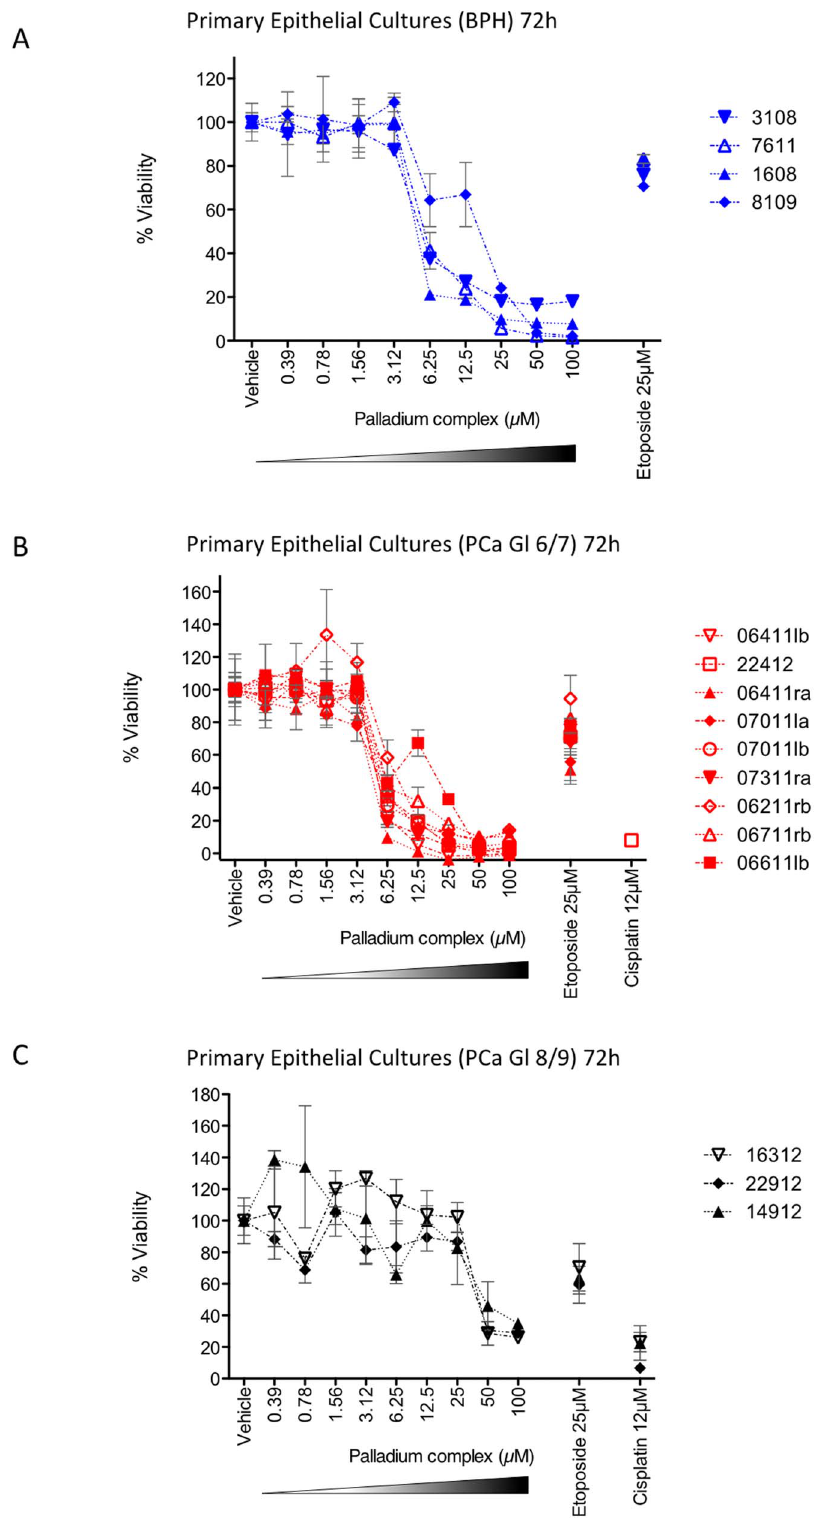
Figure 3. Anti-growth effect of the Pd complex on primary cultures. Anti-growth effect was measured by the MTS assay at 72 h using cells derived from patients with (A) benign prostate hyperplasia, (B) prostate carcinoma with Gleason grade 6/7 and (C) prostate carcinoma with Gleason grade 8/9. IC 50s are presented in Table 4. Transformed graphs are presented in Supplementary Figure S2.